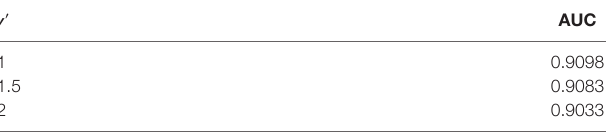
TABle 1 | The AUC of KATZBNRA with γ′set different values.